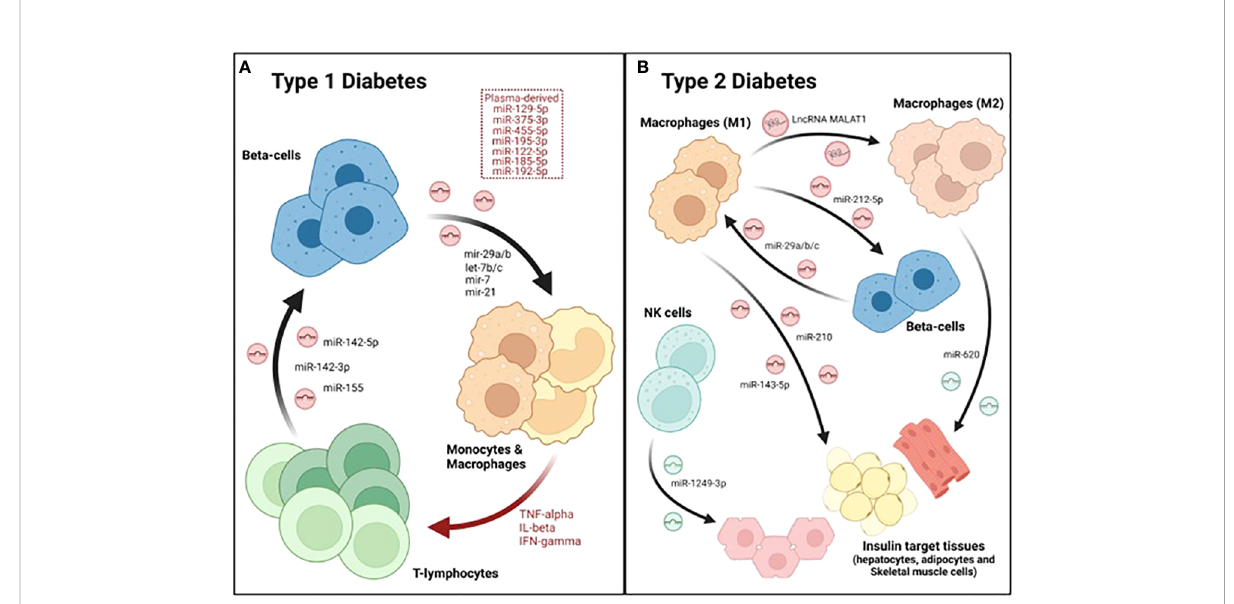
FIGURE 2 Dialogue between immune and b -cells as well as other metabolic tissues during DM. A crosstalk between immune cells, especially macrophages, pancreatic endocrine cells and insulin-target tissues occurs during the major forms of diabetes. (A) During T1DM, b -cells secrete several exosomal miRNAs that stimulate monocytes and macrophages. These antigen presenting cells (APCs) then activate T cells, which also secrete several miRNAs that induce apoptosis in b -cells, initiating a vicious cycle that culminates with the destruction of the majority of b -cell mass. (B) In type 2, M1-derived exosomes contain several miRNAs that reduce beta-cell function and/or insulin sensitivity. Furthermore, the lncRNA MALAT1, also found in M1-derived exosomes, polarizes other macrophages towards a M1-like phenotype, further worsening disease progression. In contrast, exosomes released by M2 and NK cells attenuate insulin resistance though the action of miRNAs such as miR-620 and miR-1249-3p,